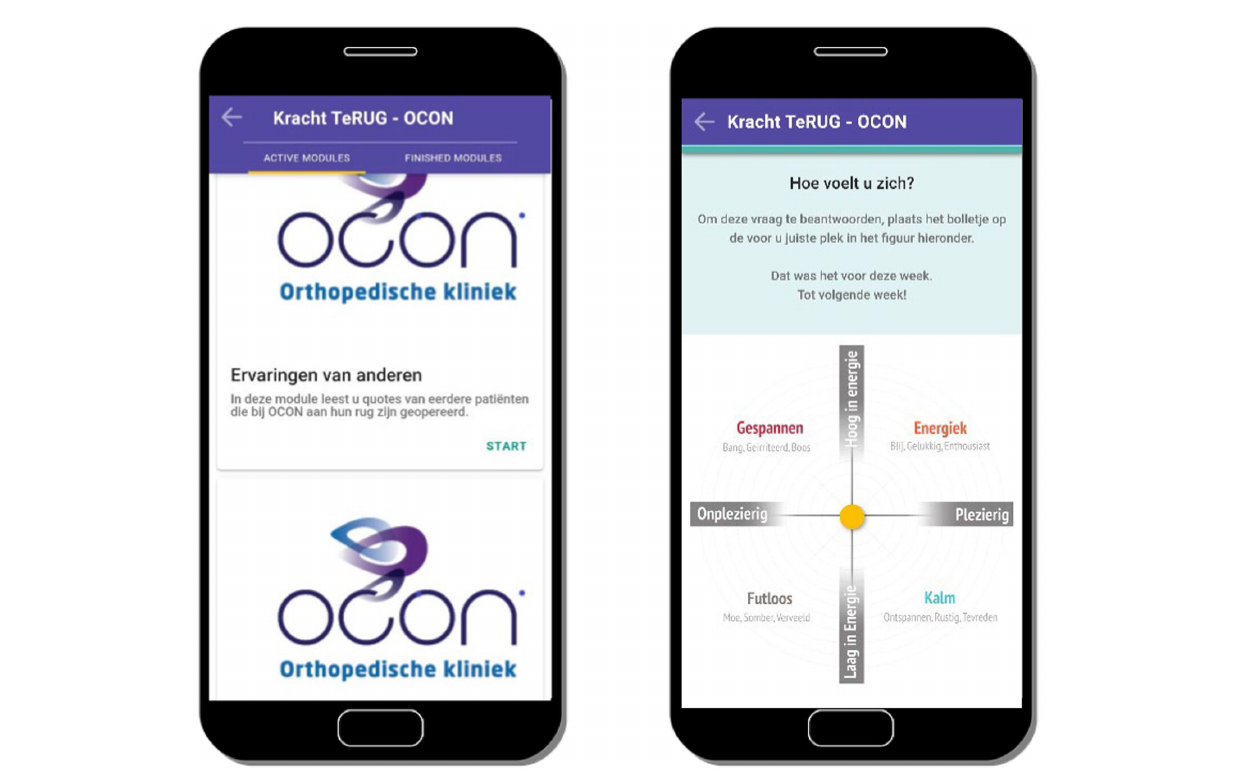
FIGURE 2 Screenshots of the first version of the intervention Strength Back showing the start screen of the module on experiences of previous patients (left) and showing a question about the current emotional state of the participant